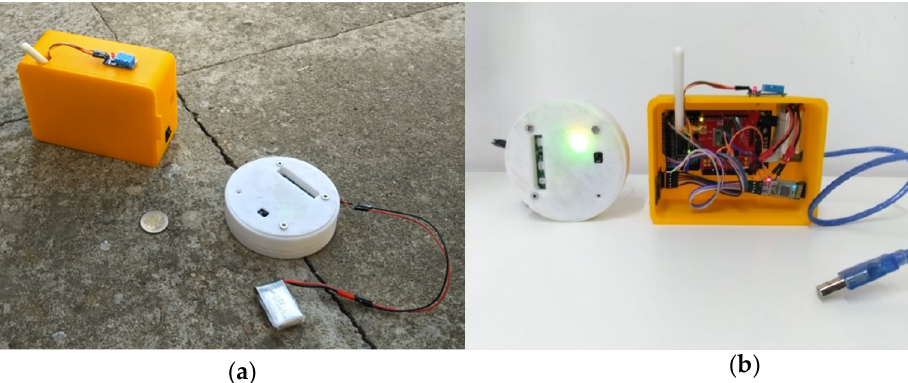
Figure 3. Beacon device along with the electronic nose. ( a ) Comparison of the components of the beacon with a coin; ( b ) presentation of the internal structure of the beacon.